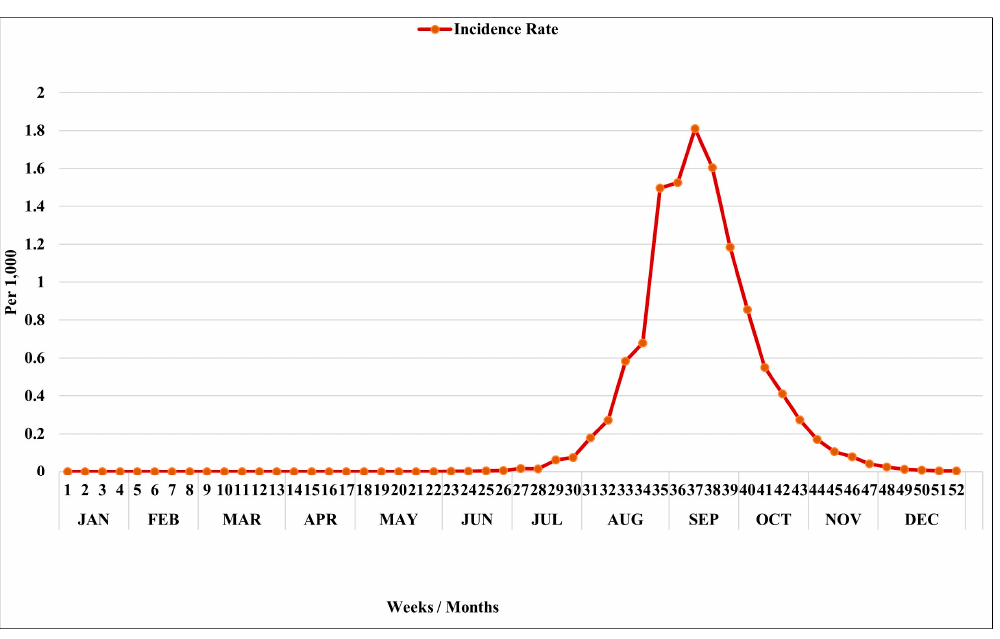
Figure 2. Weekly dengue incidence rate (per 1000) in Tainan City, 2015.